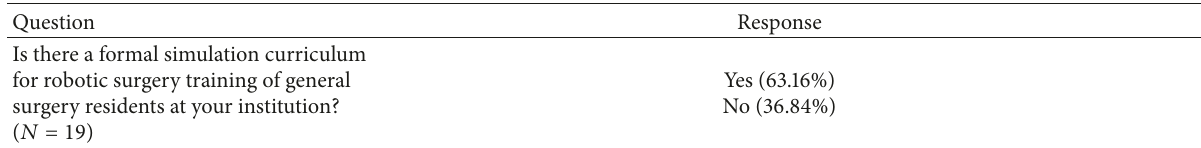
Table 4: Current robotic surgery education method.